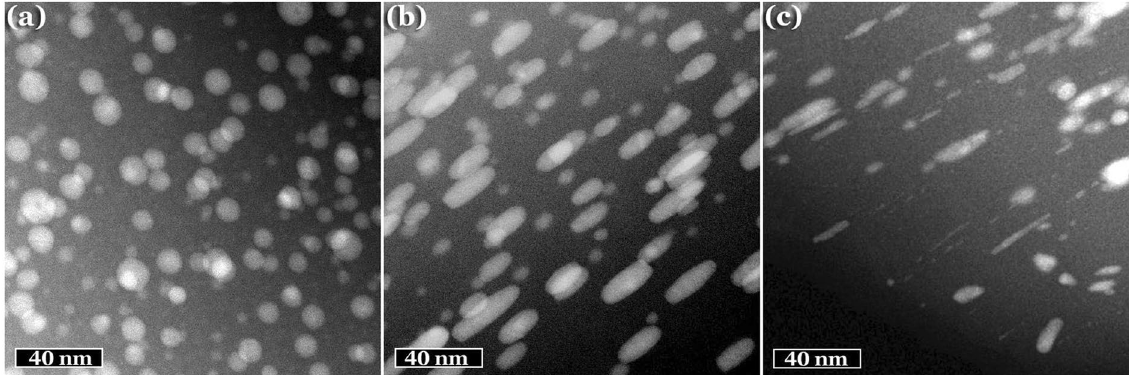
Figure 3. Low magnification HAADF-TEM micrographs showing the nanoparticles produced by silver implantation in silica, ( a ) as obtained and after irradiating with 40 MeV Br ions and fluences of ( b ) 8 × 10 13 cm − 2 and ( c ) 1.5 × 10 14 cm − 2 . In Figures ( b,c ) the Br ion beam impinged parallel to the NP elongation.